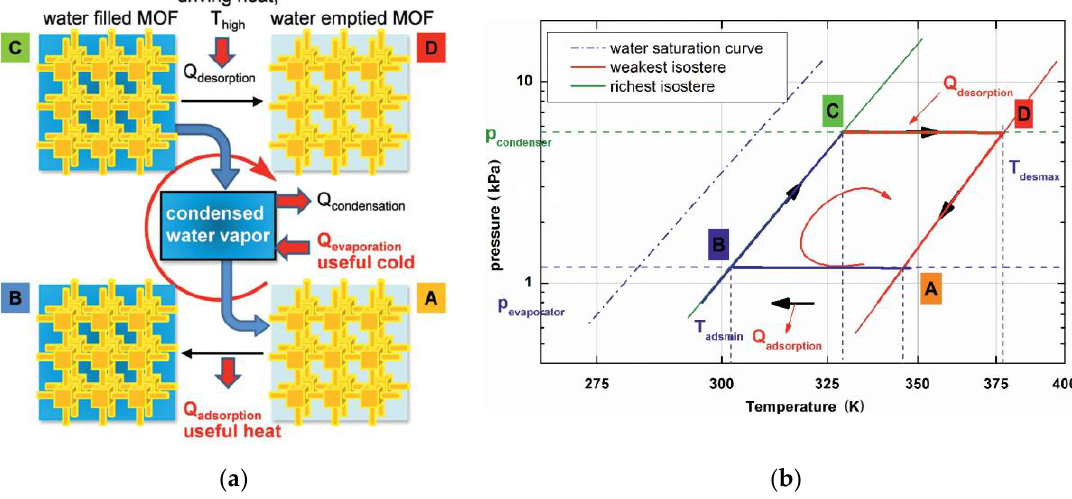
Figure 4. Principle process of the ideal cycle in an adsorption heat-pump or chiller process ( a ) and diagram ( b ). A → B: production or adsorption cycle. C → D: regeneration or desorption cycle Reproduced with permission from [18]. Wiley, 2011; [45]. Wiley, 2011.